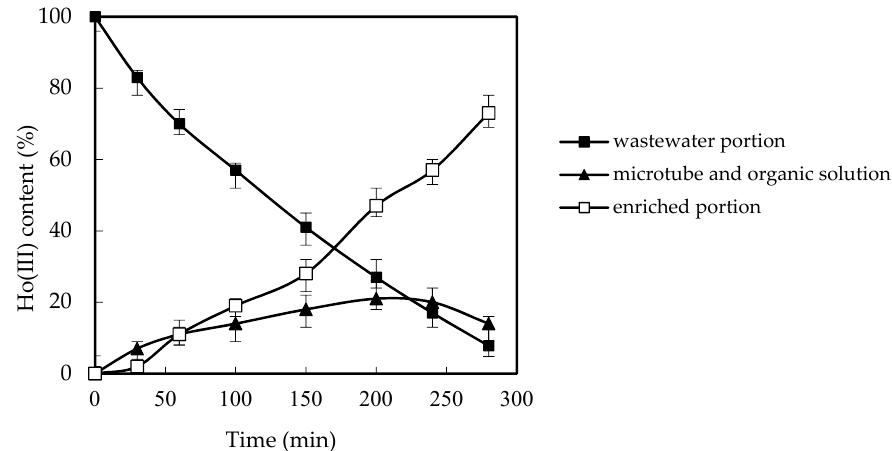
Figure 12. Retention in microtubes and resolving influences.